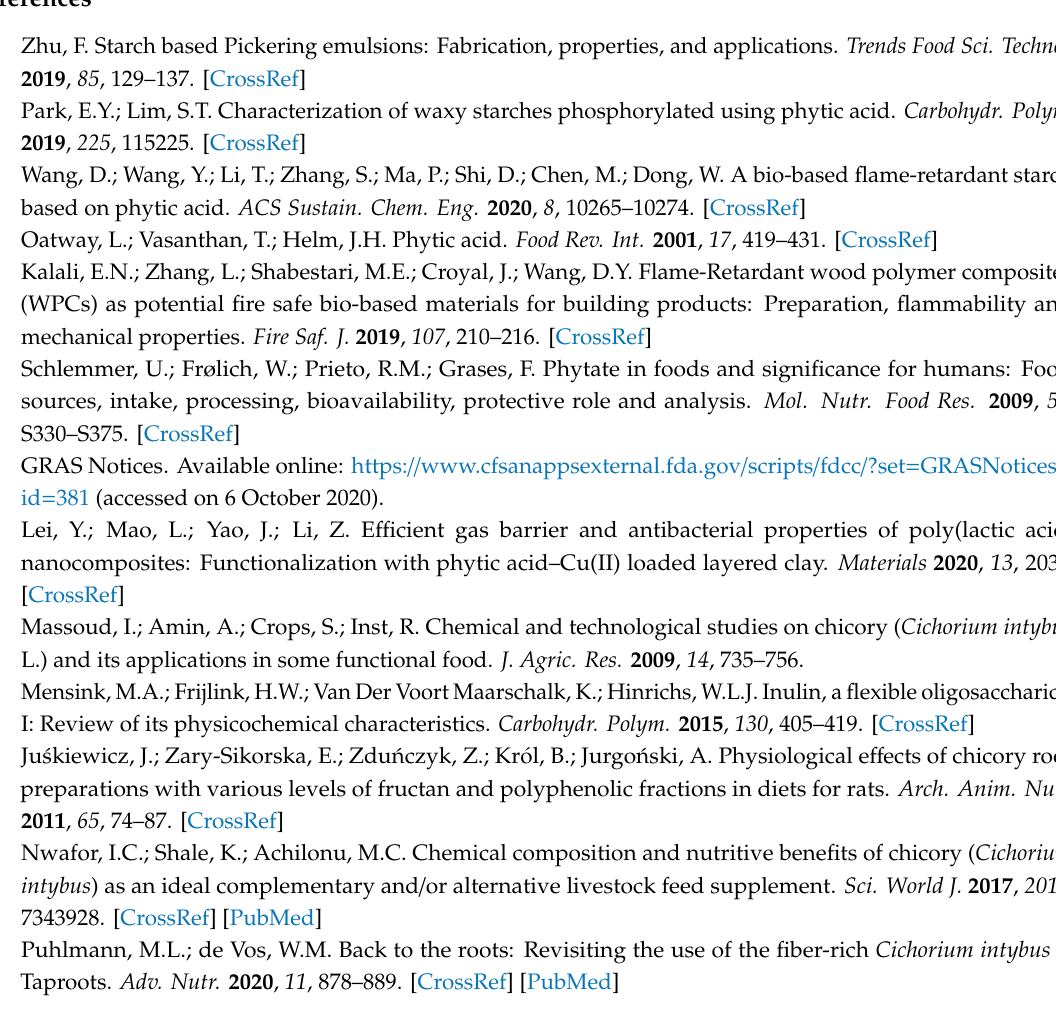
Figure S1: Representative images showing the structure of foil using a scanning electron microscope (SEM), Table S1: Thickness spread for one film measured at 5